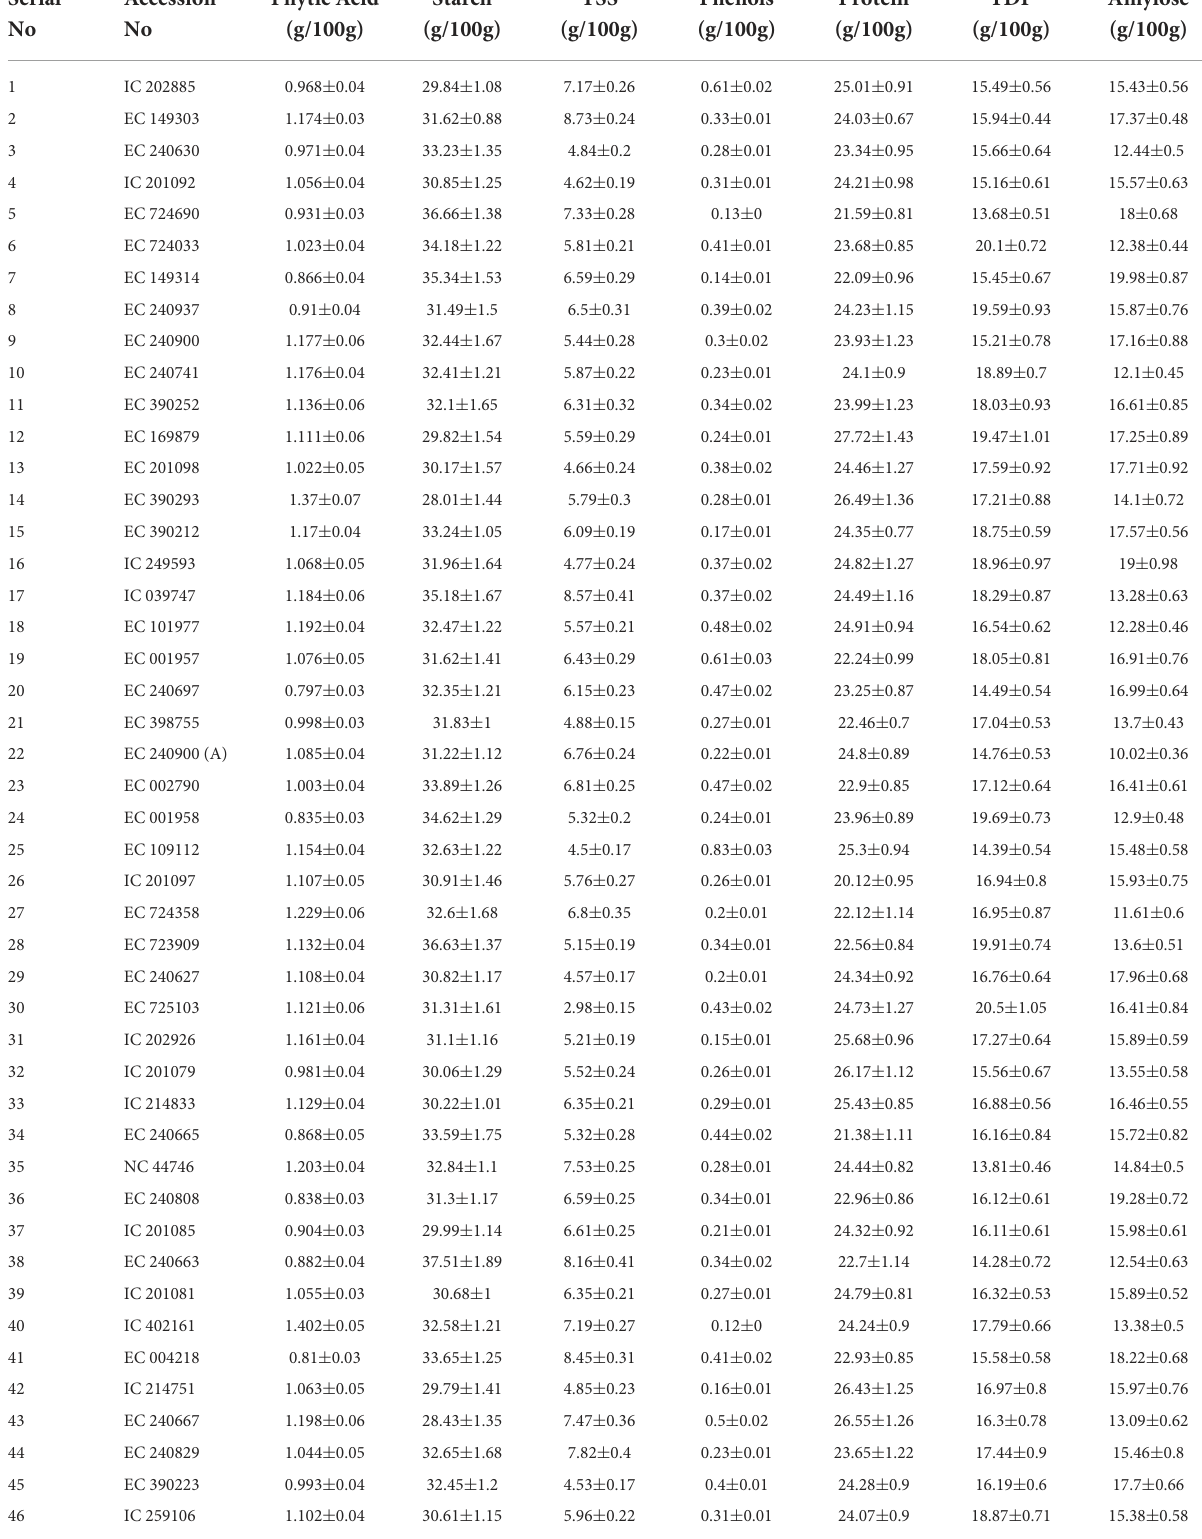
SUPPLEMENTARY TABLE 1 Nutritional composition of 120 cowpea germplasm, values expressed as mean ± standard